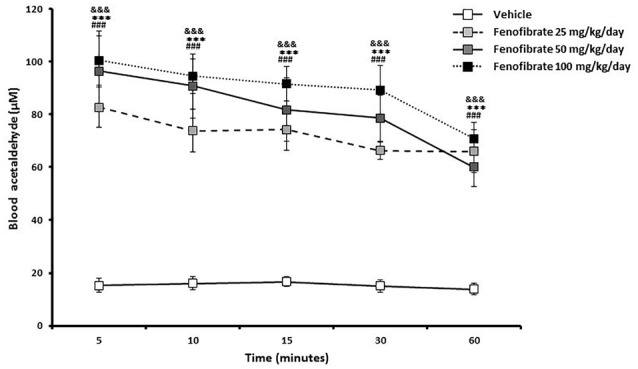
Blood acetaldehyde levels in fenofibrate-treated animals after a single oral dose of ethanol. UChB rats were allowed to voluntarily drink 10% v/v alcohol and water for 60 days on a 24-h basis. On the subsequent 14 days, 25, 50 or 100 mg/kg/day fenofibrate was given orally to three groups (n = 7) while the control group (n = 7) was given vehicle. Thereafter, animals were deprived from ethanol access for 24 h and ethanol (1 g/kg) was administered orally to both fenofibrate-treated and control (vehicle) animals. Blood samples for acetaldehyde measurement were drawn from the carotid artery at different times. Deviations shown are SEM.; two-way ANOVA test indicates that blood acetaldehyde levels in the fenofibrate-treated group were significantly higher than in the control group (&&&p < 0.001 for fenofibrate 25 mg/kg/day vs. vehicle; ***p < 0.001 for fenofibrate 50 mg/kg/day vs. vehicle; ###p < 0.001 for fenofibrate 100 mg/kg/day vs. vehicle).